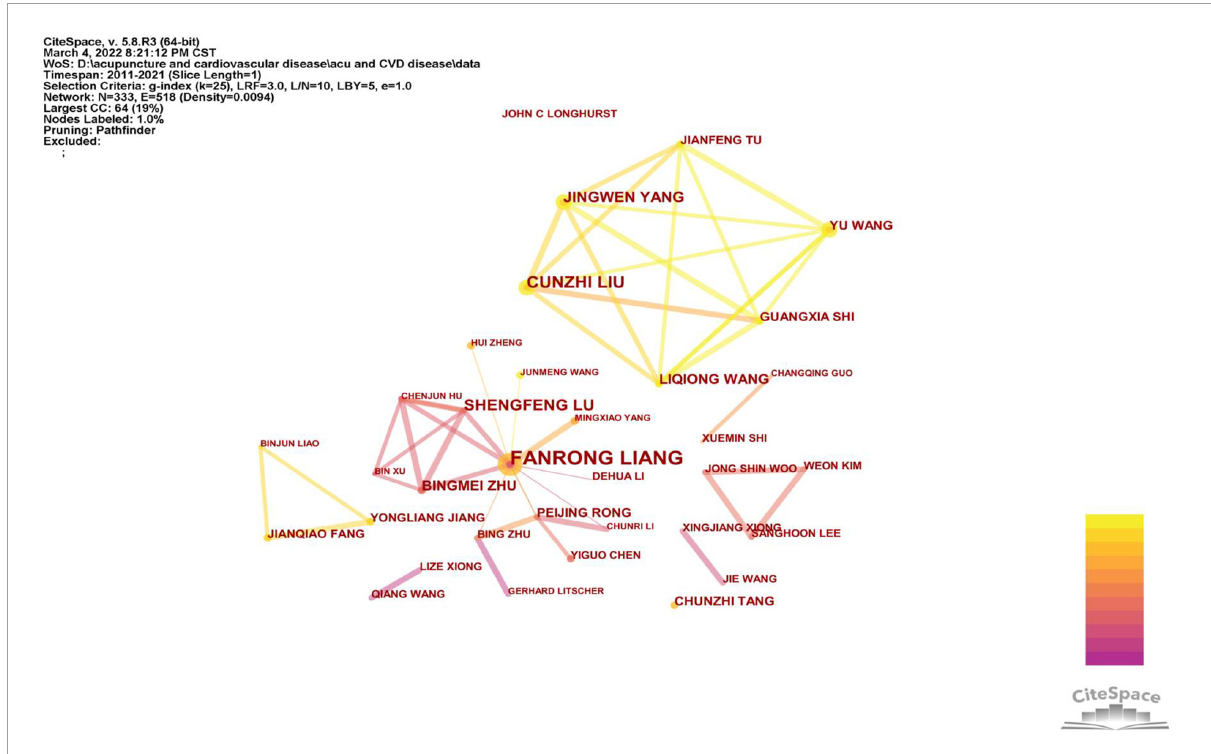
FIGURE4 Network map of co-authorship between authors about acupuncture on cardiopathy.